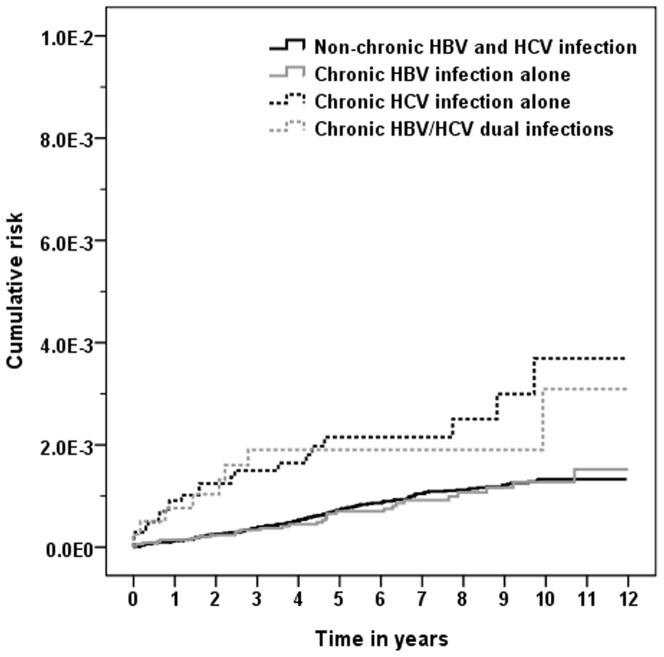
Cumulative risk of rheumatoid arthritis in chronic hepatitis virus infection and non-chronic HBV and HCV infection comparison cohorts over the 11-year follow up period.Log-rank test: Four cohorts, P<0.0001; non-chronic HBV and HCV infection comparison cohort vs. chronic HBV infection alone cohort, P = 0.834; non-chronic HBV and HCV infection comparison cohort vs. chronic HCV infection alone cohort, P<0.0001; non-chronic HBV and HCV infection comparison cohort vs. chronic HBV/HCV dual infections cohort, P = 0.023.